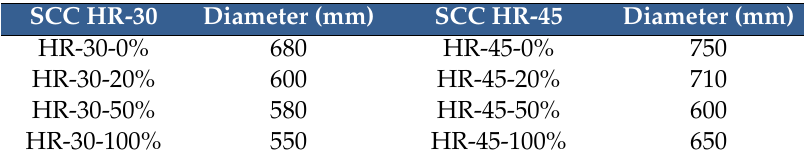
Table 4. Results of fresh concrete consistency.